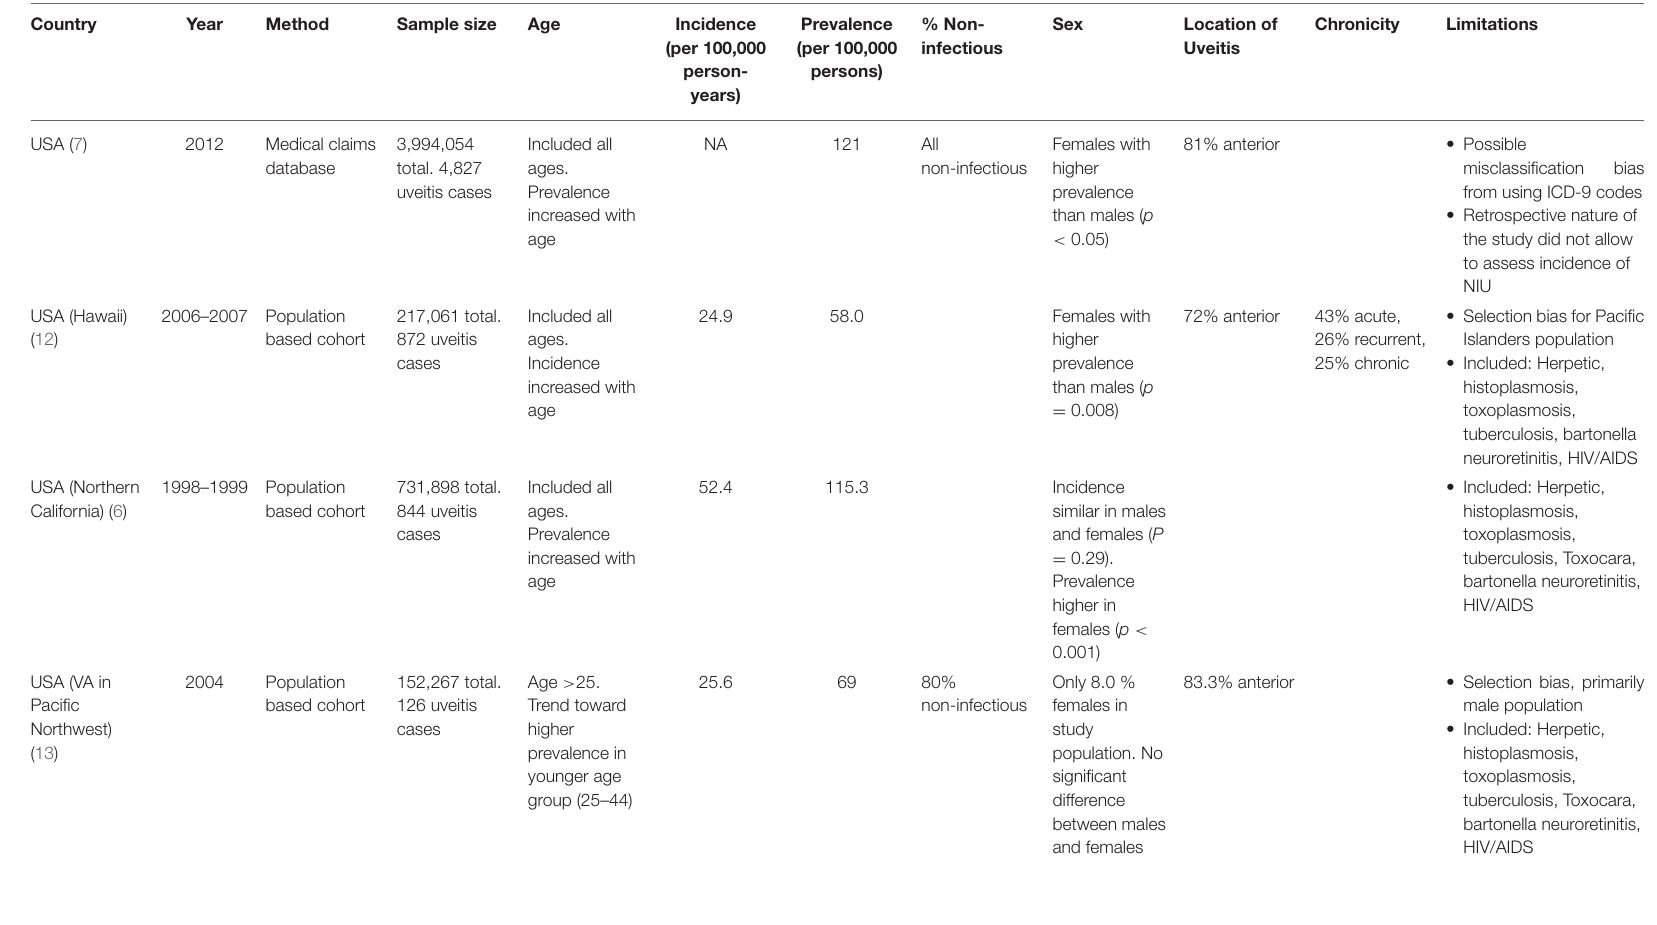
TABLE 1 | Large population-based epidemiologic studies of uveitis in the United States.